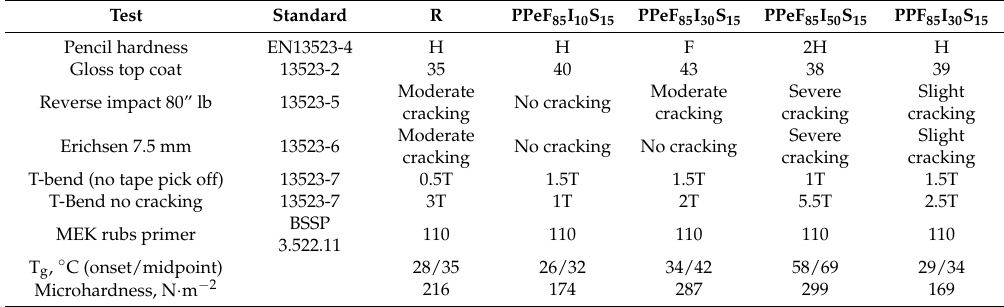
Table 6. Physical test results on white paints based on polyesters PPeF 85 I 10 S 15 , PPeF 85 I 30 S 15